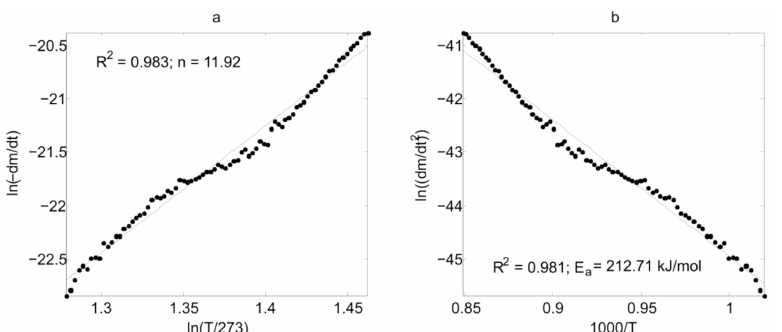
Figure 4. Results of processing of the TG curve of charcoal gasification at a heating rate of 10 K min − 1 using the equation of diffusion ( a ) and pore-diffusion kinetics ( b